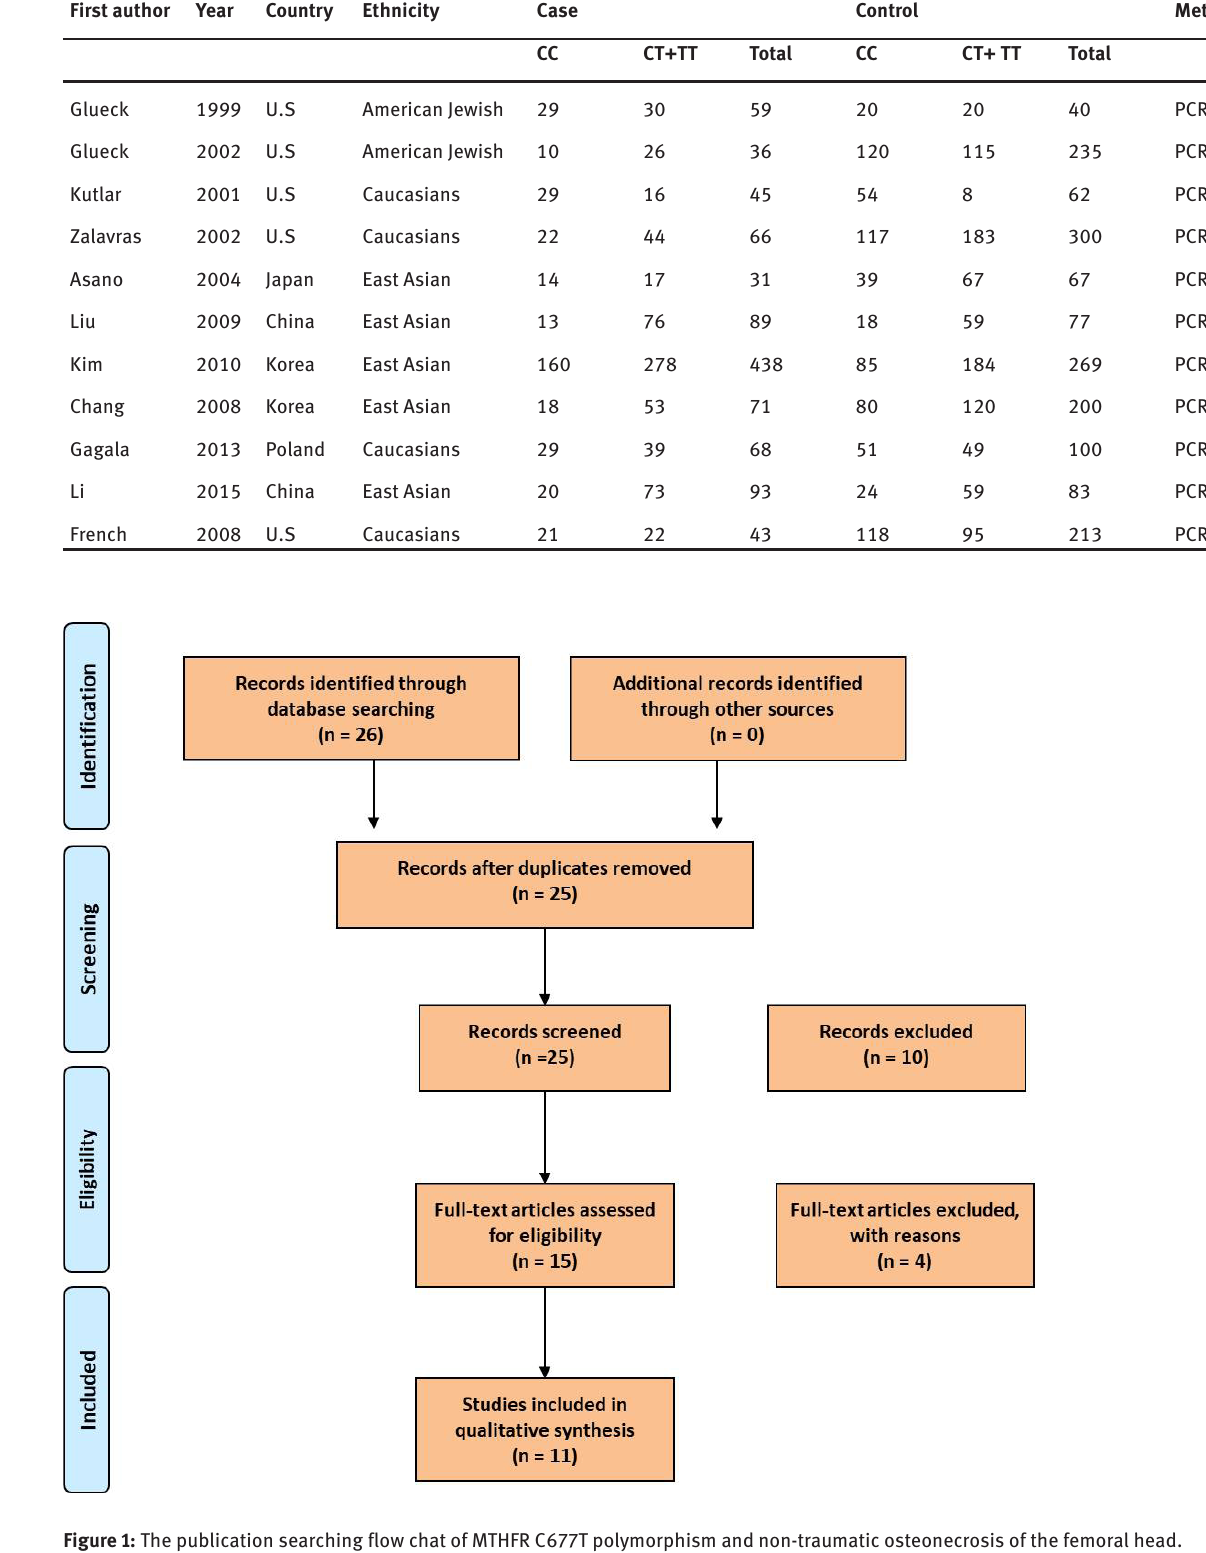
Figure 1: The publication searching flow chat of MTHFR C677T polymorphism and non-traumatic osteonecrosis of the femoral